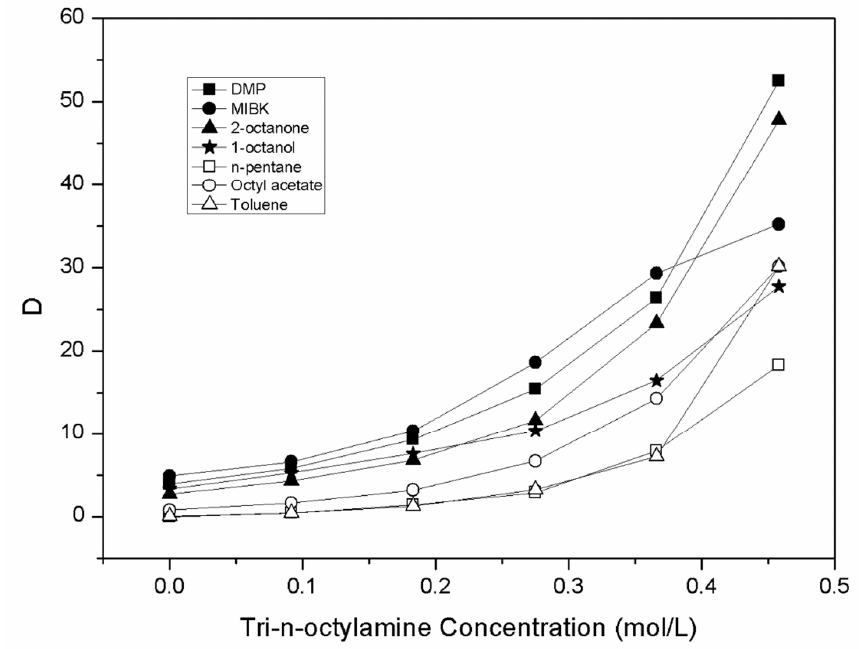
Figure 2. Plot of the distribution coefficients (D) versus the molar concentrations of TOA (C TOA,org ) in different